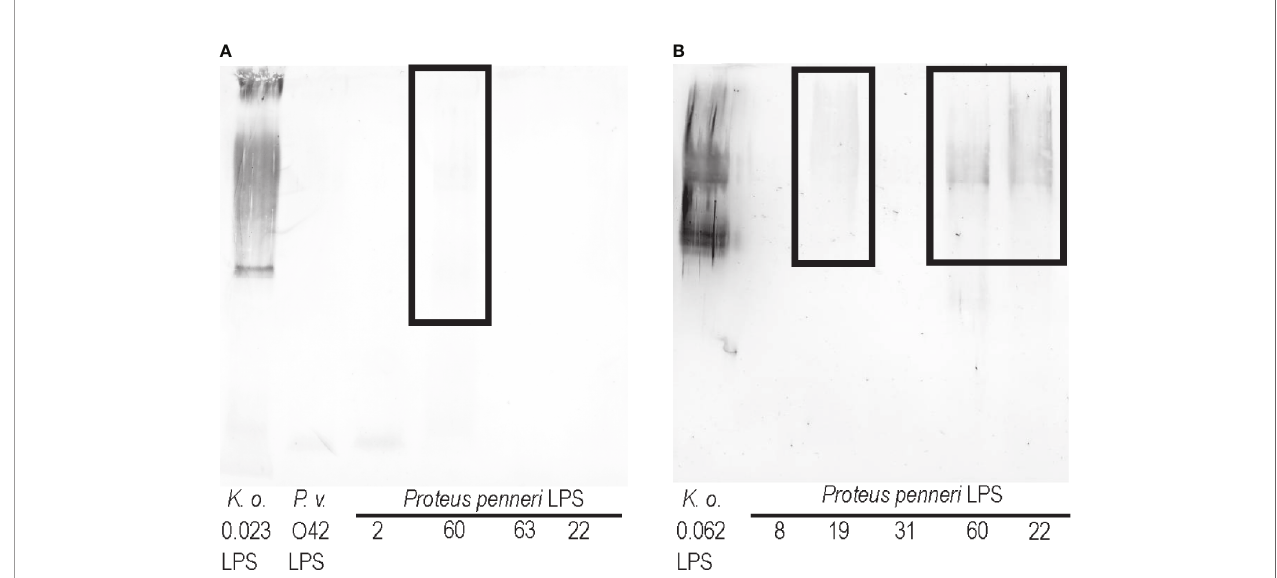
FIGURE 3 | Western blotting reactions of (A) K. oxytoca 0.023 serum and (B) K. oxytoca 0.062 serum with Proteus spp.